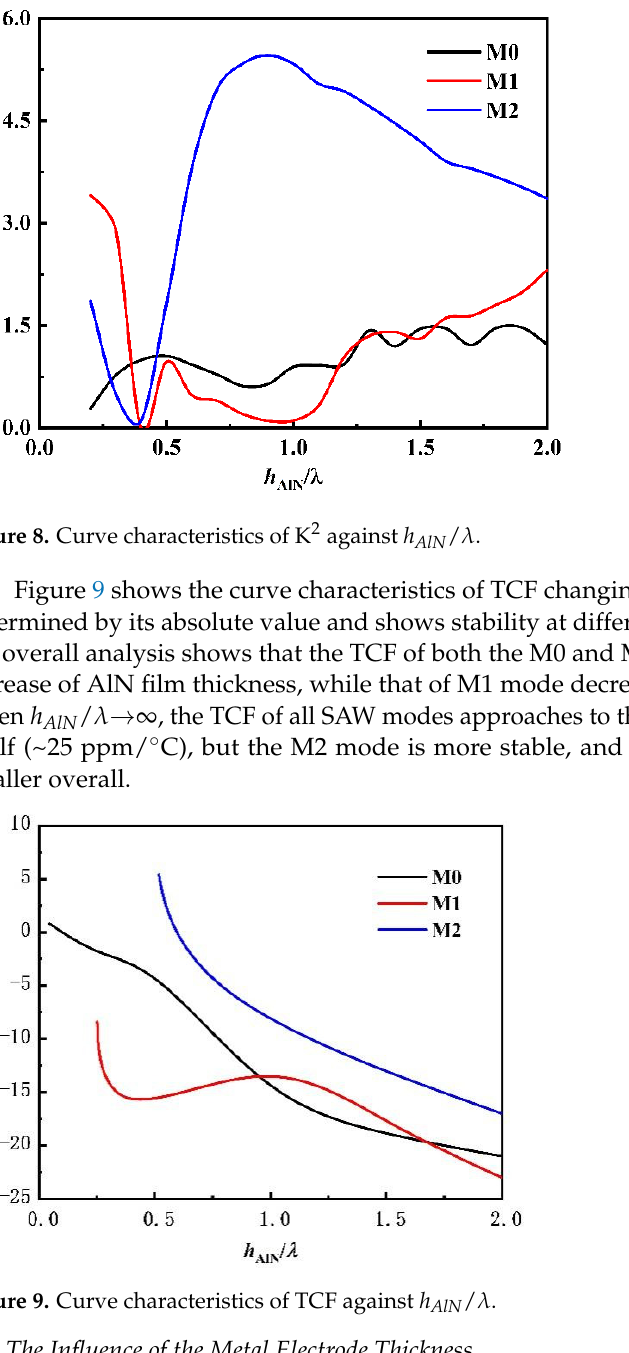
Figure 9. Curve characteristics of TCF against h AlN / λ .